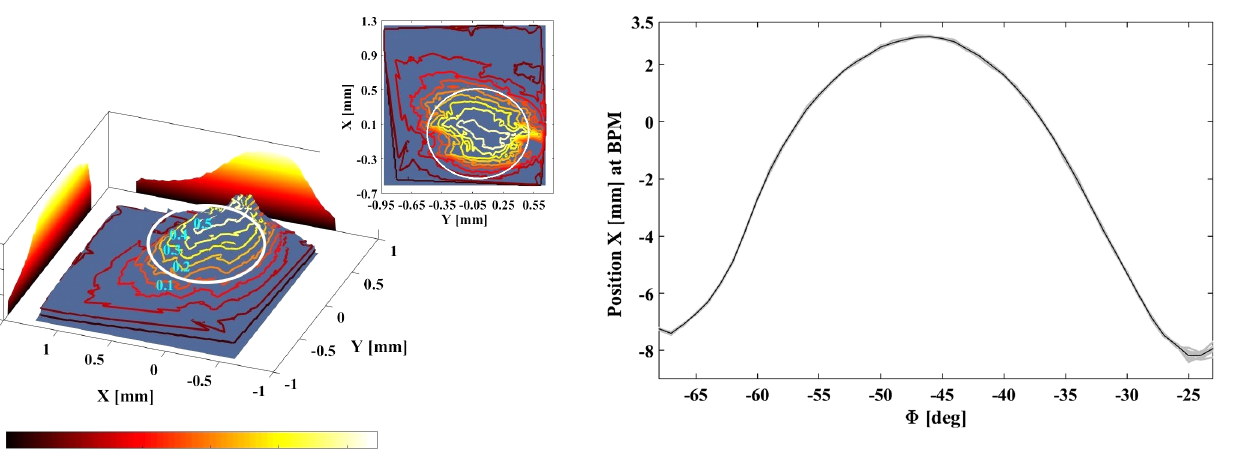
FIG. 6. Horizontal beam positions measured by a BPM in a dispersive arm downstream the gun after a dipole magnet versus rf phases. Note that the estimated dispersion for the BPM located in the gun dispersive arm is 0.424 m, and that, the typical position resolution in BPM measurements is up to a few micrometers at the European XFEL.